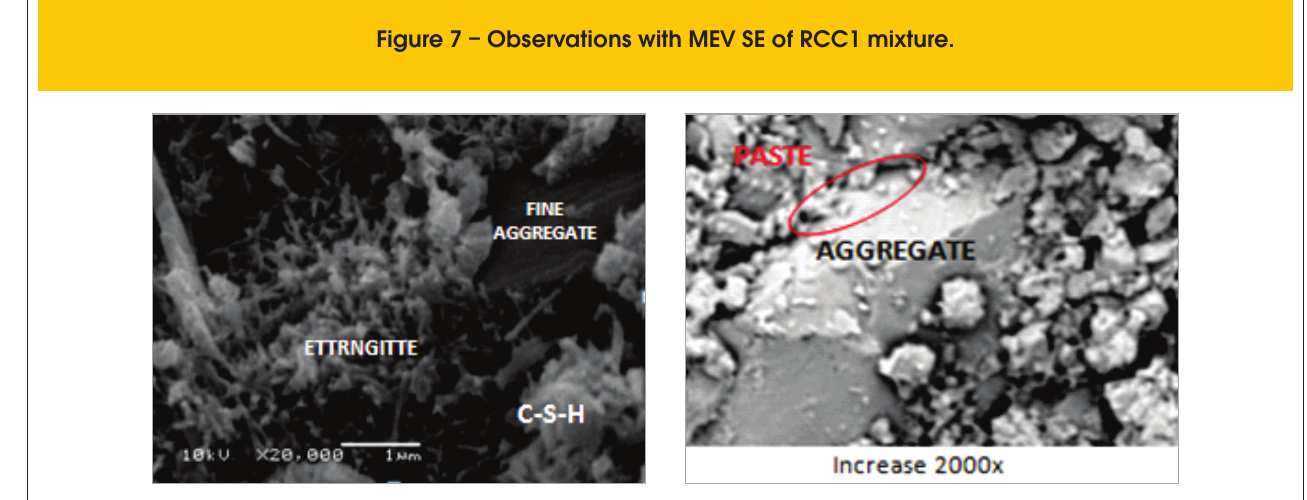
Figure 7 – Observations with MEV SE of RCC1